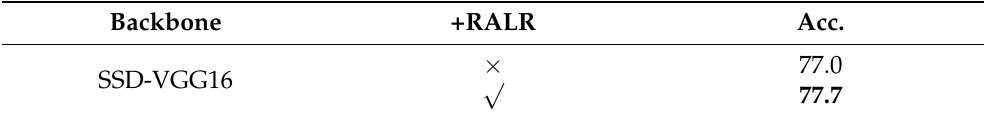
Table 4. Comparison results of SSD on PASCAL VOC